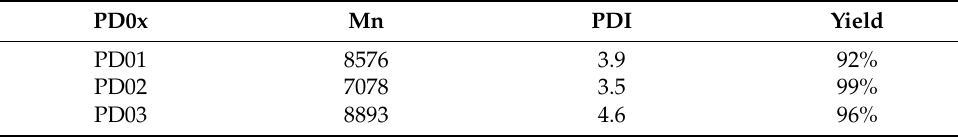
Table 3. Molecular weights and yields of dispersants